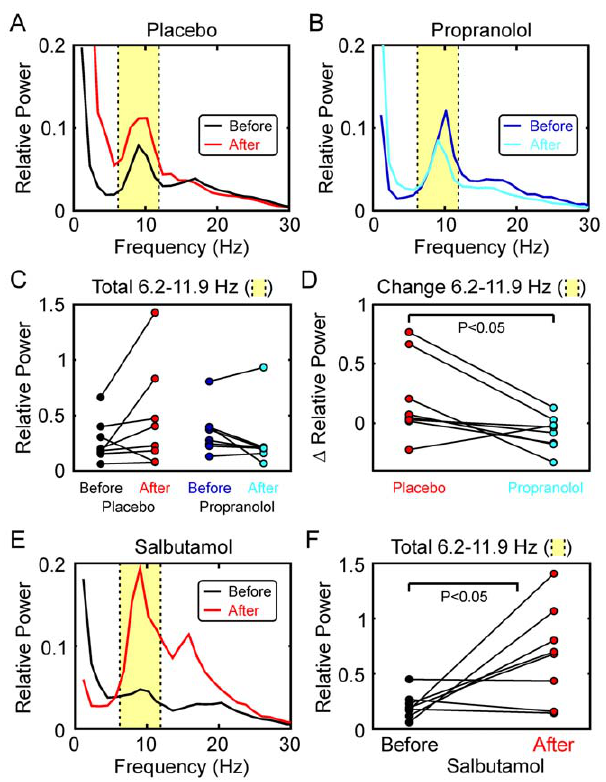
Figure 3. Effects on Resting Tremor. All measurements in this figure were taken during index finger extension. A, B, changes in finger acceleration power spectra, averaged across all eight subjects, before and after administration of placebo (A) and propranolol (B). C, total acceleration power over the 6.2–11.9 Hz range (yellow shading in A,B) before and after substance administration. Each point shows data from one subject; lines link data from the same subject. Data points are colour coded to match the colours used in (A,B). There was no significant change in tremor power after either placebo or propranolol. D, changes in tremor power after administration of placebo or propranolol. Each point shows the difference between the ‘after’ and ‘before’ points from the corresponding subject shown in (C). Propranolol reduced tremor power significantly compared to placebo (P , 0.05). E, changes in finger acceleration power spectra, averaged across all eight subjects, before and after administration of salbutamol. F, total acceleration power over the 6.2–11.9 Hz range (yellow shading in E) before and after salbutamol administration. Tremor power was significantly increased after salbutamol (P ,